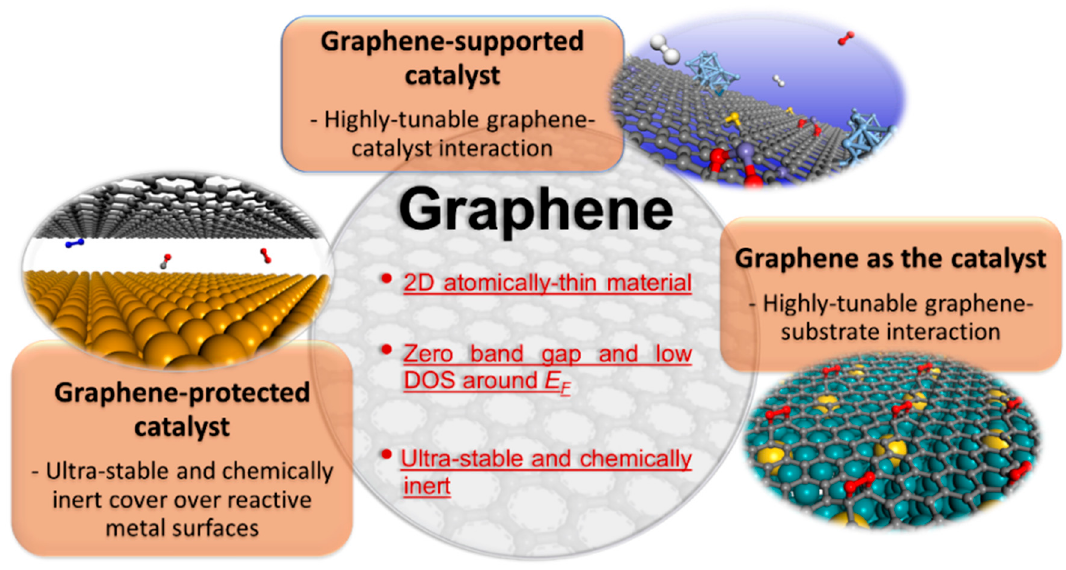
Figure 1. Different roles of graphene in graphene-based solid-state catalysts. Graphene can act as a